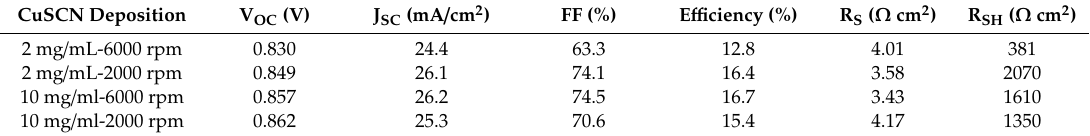
Figure 4. Statistical results for MZO / CdTe solar cell performances of ( a ) PCE, ( b ) V OC , ( c ) FF, ( d ) J SC , ( e ) series resistance (R S ), and ( f ) shunt resistance (R SH ) with different CuSCN film thicknesses tuned by varying the solution concentration and the spin-coating speed. Table 3. The device performance of the best cells with different CdTe-CuSCN thickness.